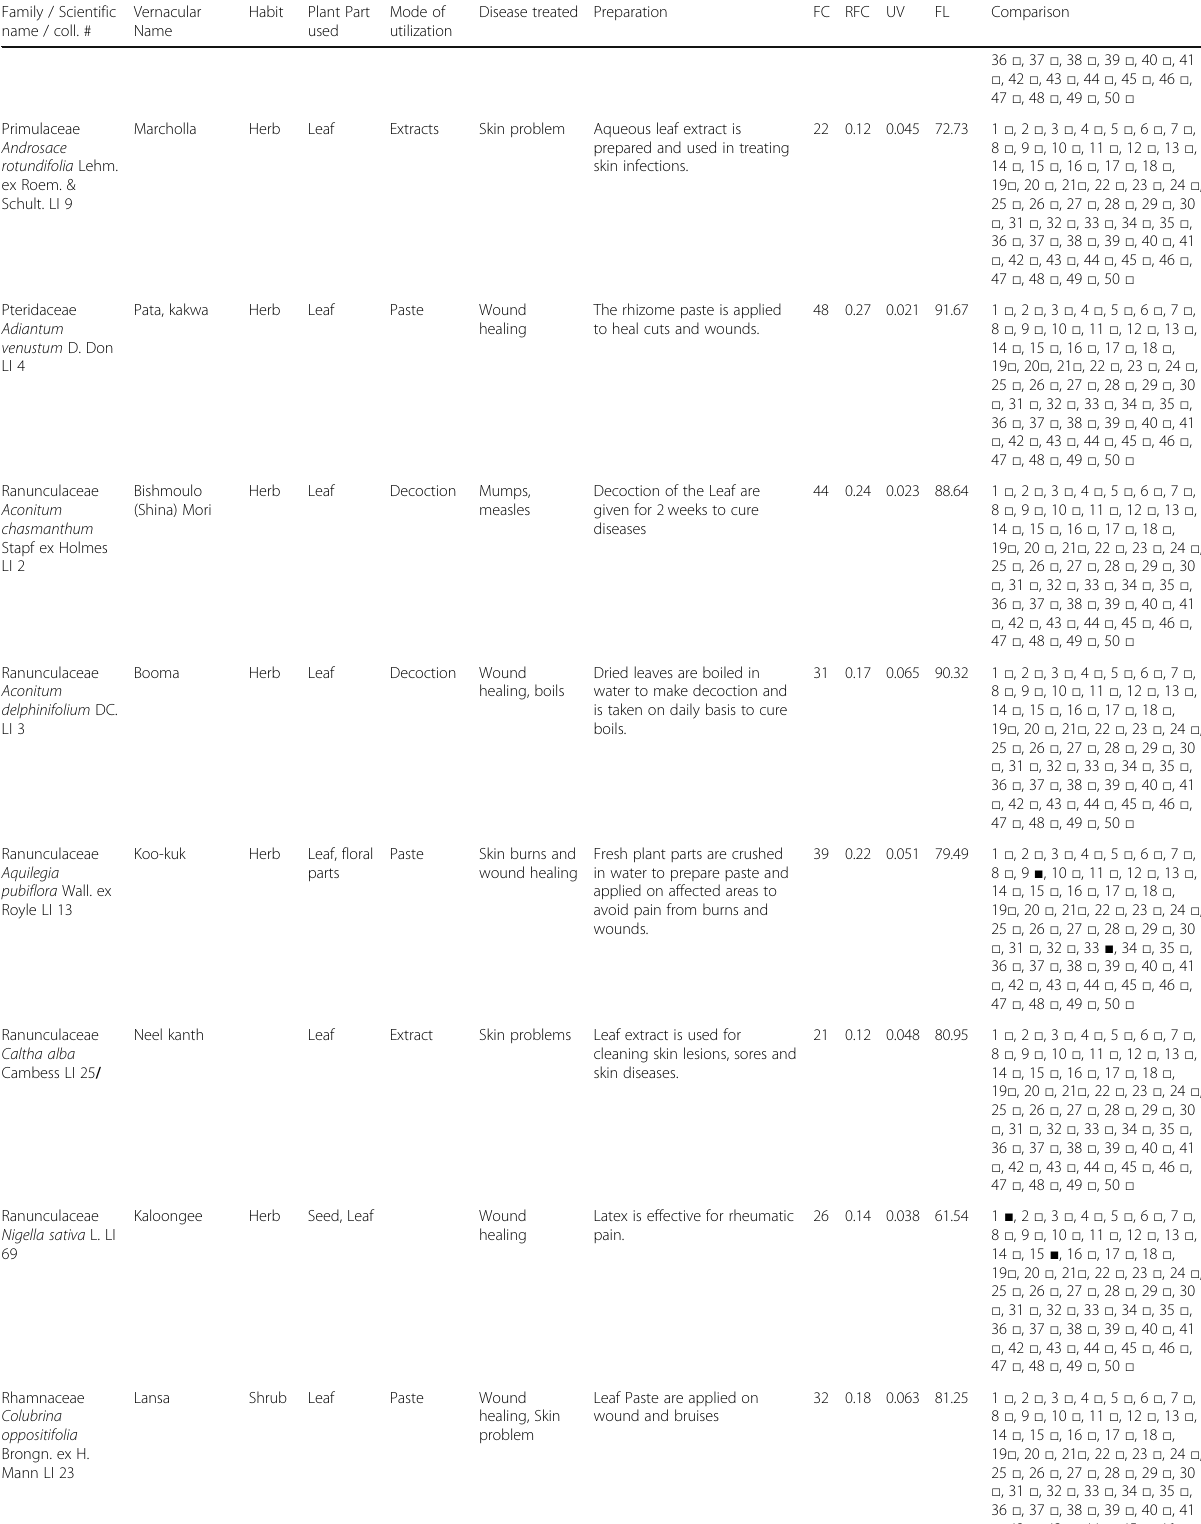
Table 2 Medicinal plants used for skin diseases in Northern Pakistan (Continued) Family / Scientific name / coll.